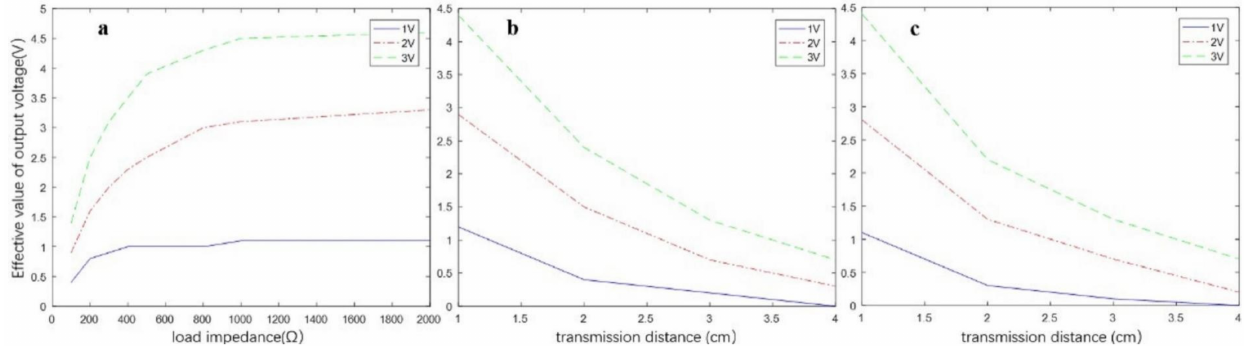
Figure 10. The results of output performance test: ( a ) the voltage effective values under different loads and supply voltages; ( b ) the transmission distance test in the air; ( c ) the transmission distance test with the 2 cm thick